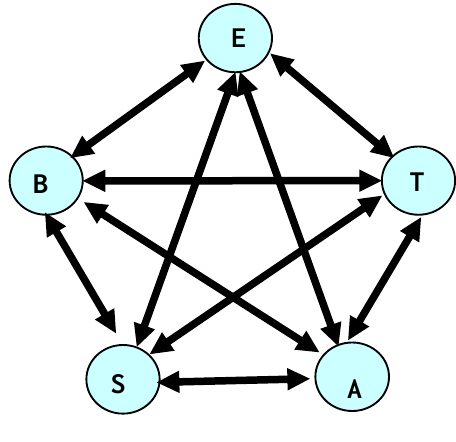
Figure 1. Sensors for a combustion system control (E: Engine revolution speed; B: Battery voltage; T: Throttle position; S: Automobile speed; A: Air flow) have as a statistical correlation with each other. The network turns out to be